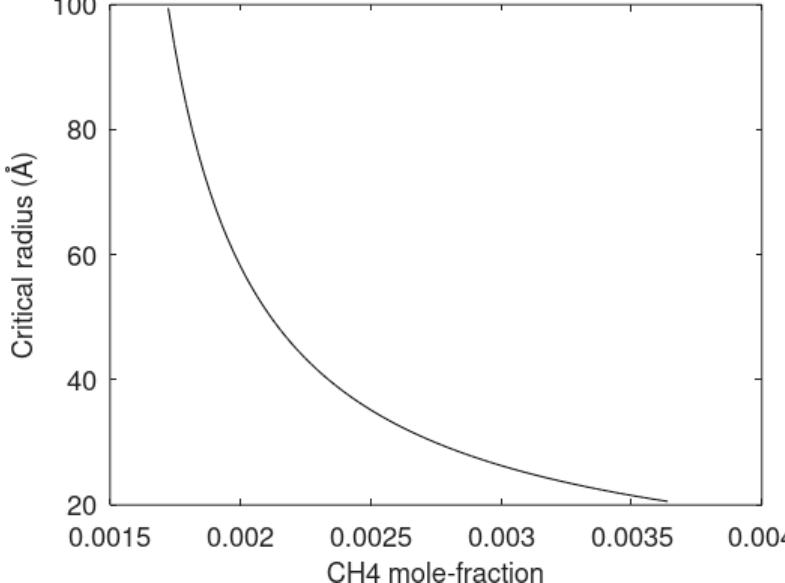
Figure 23. Critical nuclei radius for CH 4 hydrate formation from dissolved CH 4 in water, and liquid water, as function of CH 4 mole-fraction in water. Temperature 280 K and pressure 180 bar.